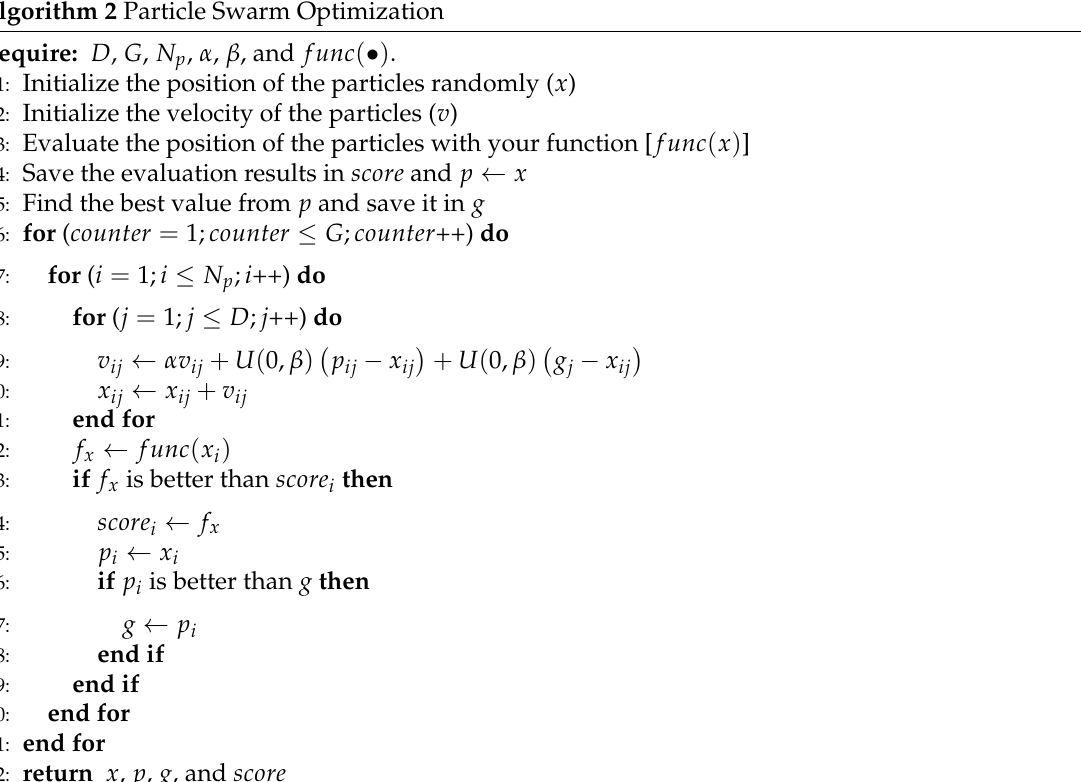
Algorithm 2 Particle Swarm